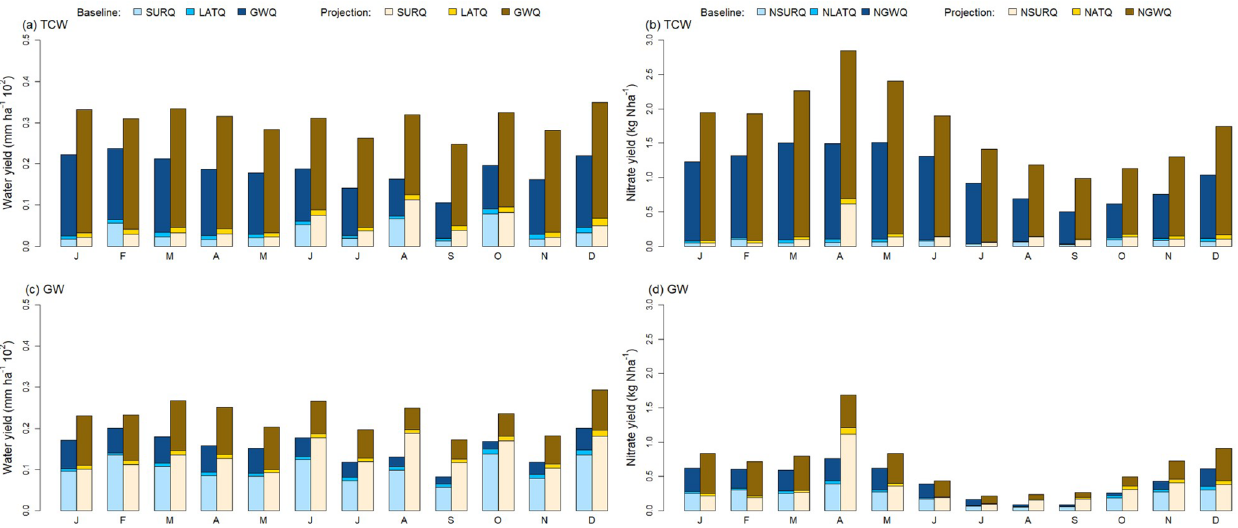
Figure 8. The 14-year average of monthly water and nitrate yields under the baseline and GCM scenarios. Note: the descriptions of abbrevi- ations are available in the caption of Fig.